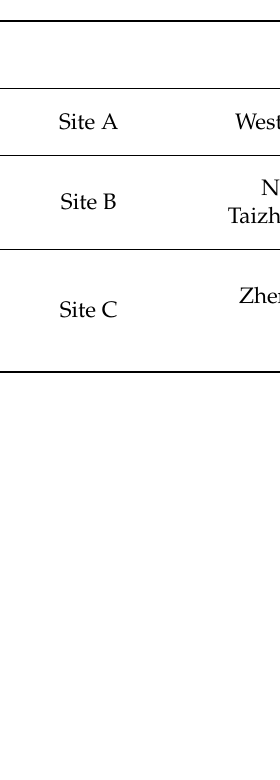
Table 2. The location and coastline types for the validation